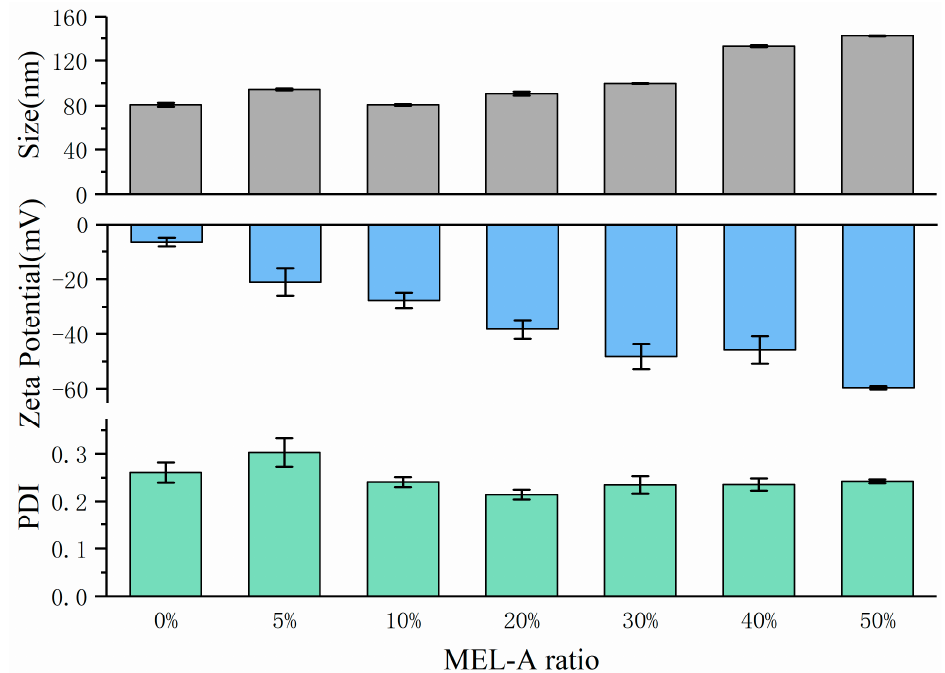
Figure 3. The effect of MEL-A adding ratio on the size, PDI and zeta potential of liposomes. SPC:CHOL was determined as 3:1. Error bars represent standard deviations (SD) ( n = 3).